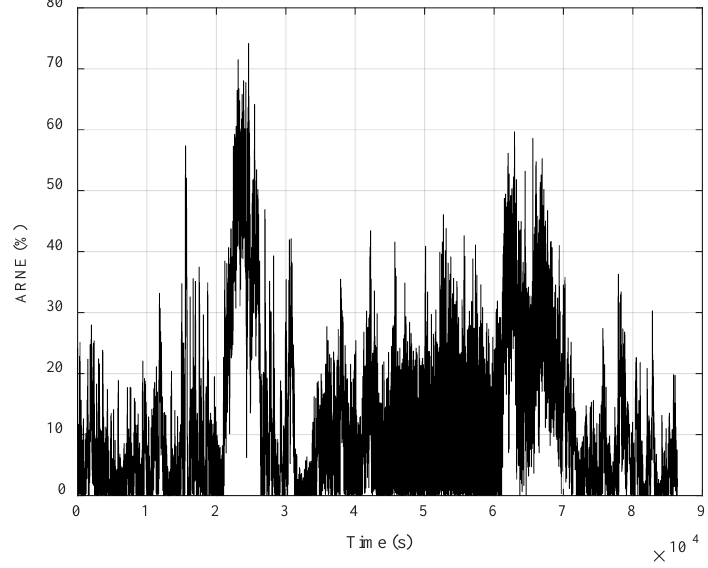
Figure 14. Absolute Range Normalized Error (ARNE) per second of 01/10/2012.